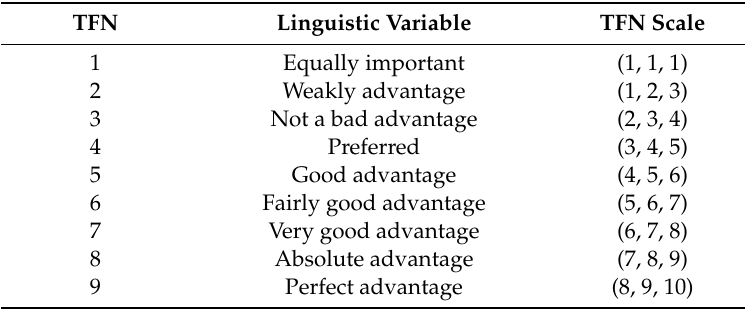
Table 1. Triangular fuzzy numbers linguistic